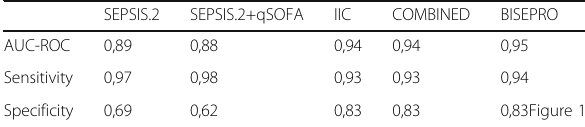
Table 1 (abstract 001142). See text for description